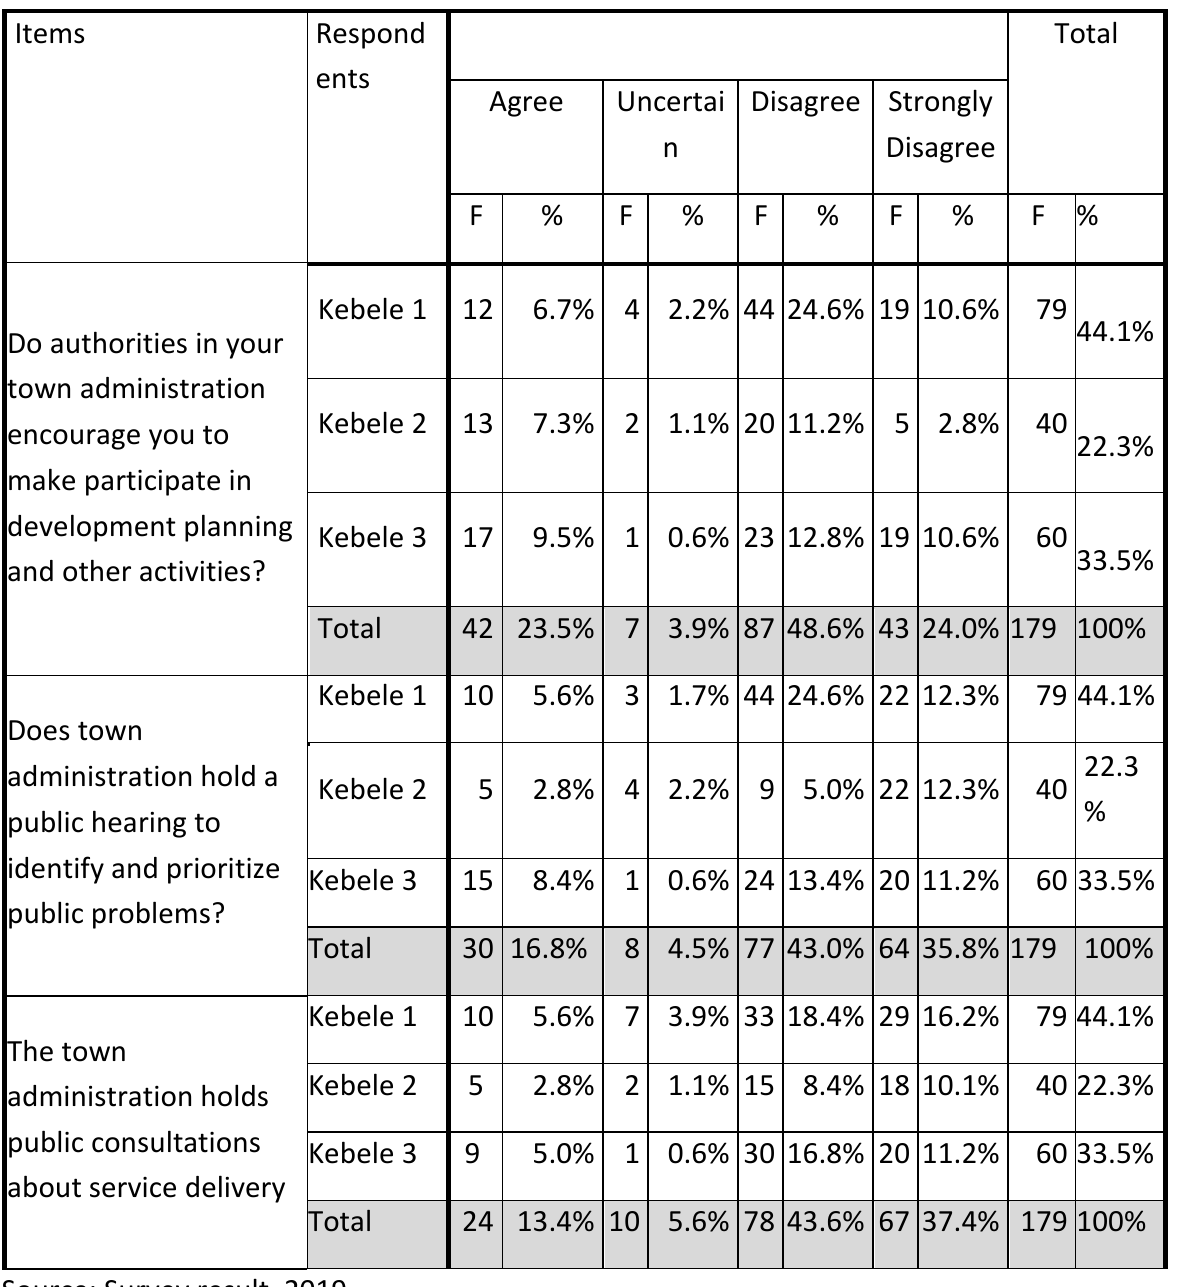
Table 8: public view regarding the town administration representatives, in encouraging the people to take part in public affairs of the town